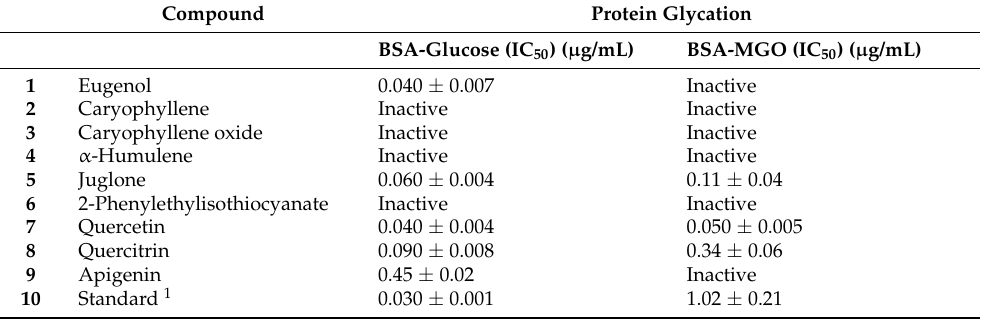
Table 6. Antiglycation assay of compounds.